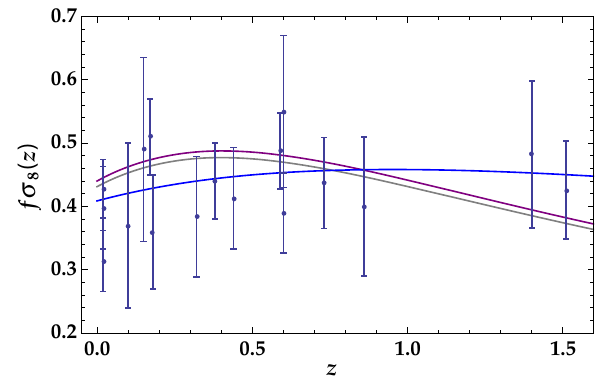
Fig. 1 Bluelinecorrespondsto w CDMbestfit,purplelinecorresponds to Planck 2015 and grey line to Planck 2018 Table 3 Values of χ 2 for the models plotted in Fig. 1. χ 2 refers LRG to the dataset in [12] whereas χ 2 refers to the data set in this work in N Table 2. The best fit parameters for w CDM with LRG data points are σ = 1 . 57, Ω = 0 . 1 and w = − 0 . 27. The tension between Planck M 8 cosmologies and w CDM for three fitted parameters is also shown in parenthesis Model